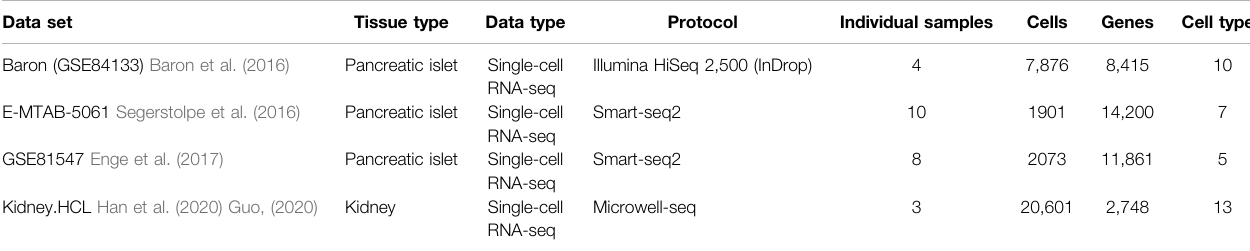
TABLE 1 | Four real scRNA-seq data